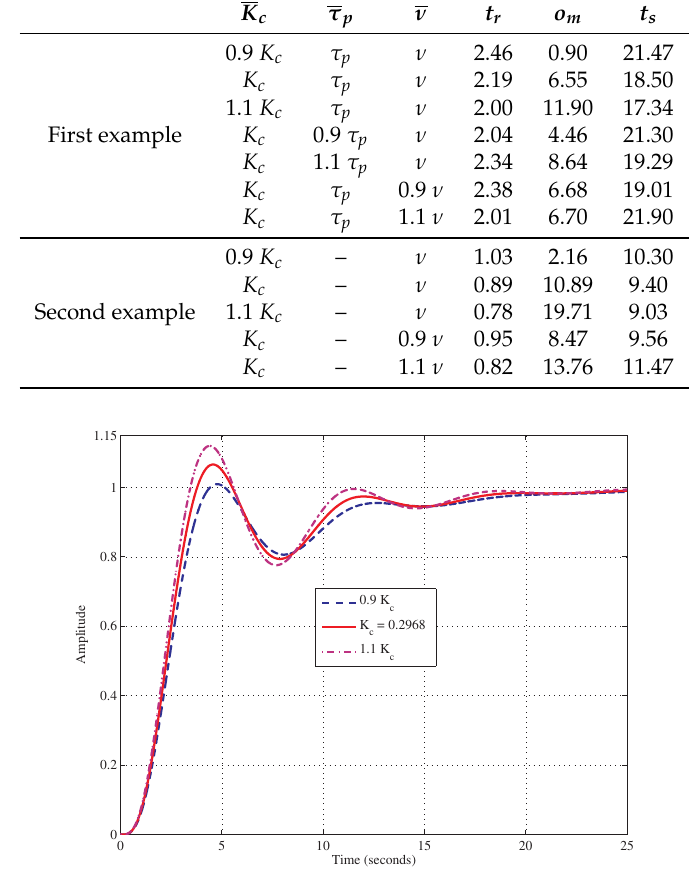
Figure 9. Unit step response in the first example for different values of K c .